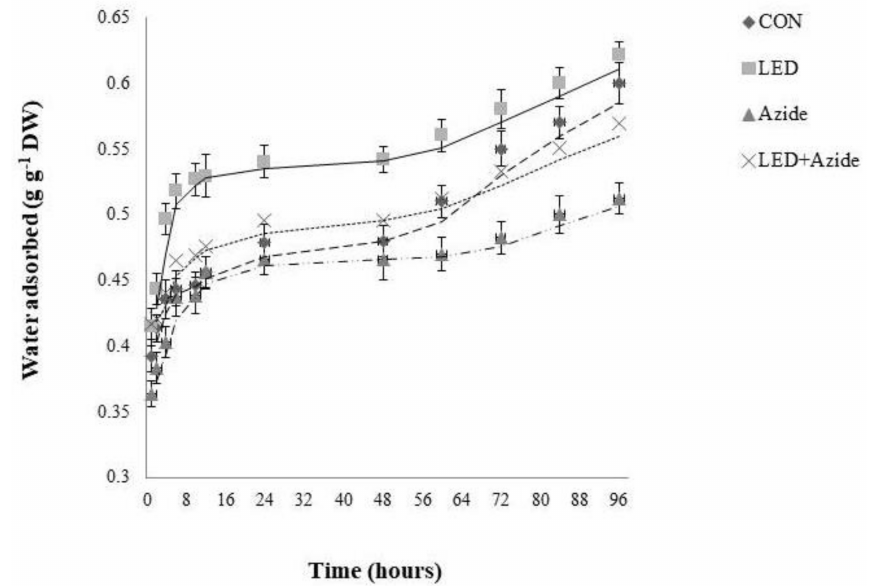
Figure 1. The water adsorption kinetics (g g − 1 DW) of pepper seeds during the imbibition initial phase (Phase I), plateau phase of germination (Phase II), and radicle emergence and growth (Phase III) under Control (CON, unlighted seeds without azide), previous pulses of R LED irradiation (660 nm) (LED, without azide), azide (azide, unlighted seeds), and azide R LED-irradiated (LED+azide) conditions. Data are the means of five repetitions ( n = 5).